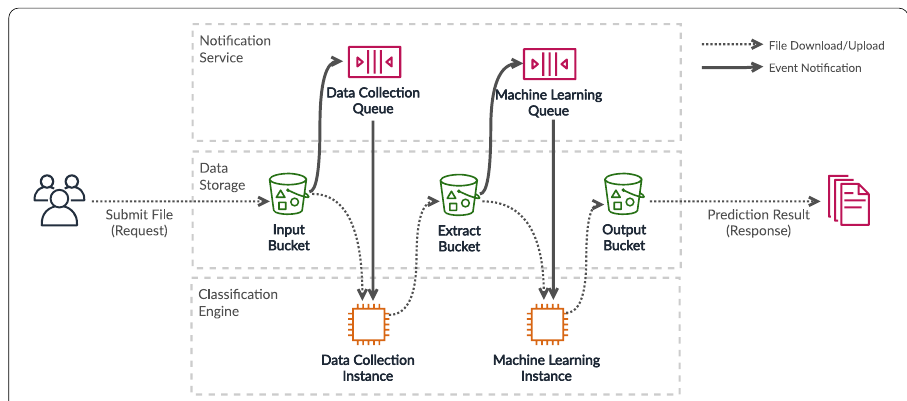
Fig. 6 System prototype for end‑to‑end QoA‑aware BIM elements